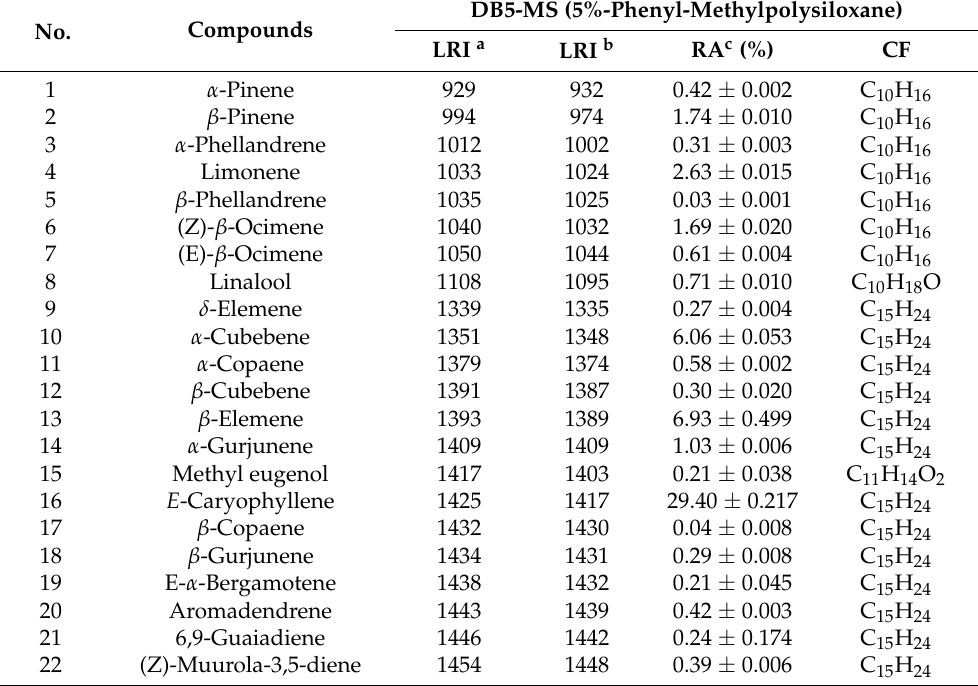
Table 1. Chemical compounds present in the essential oil of the leaves of Myrcianthes discolor .